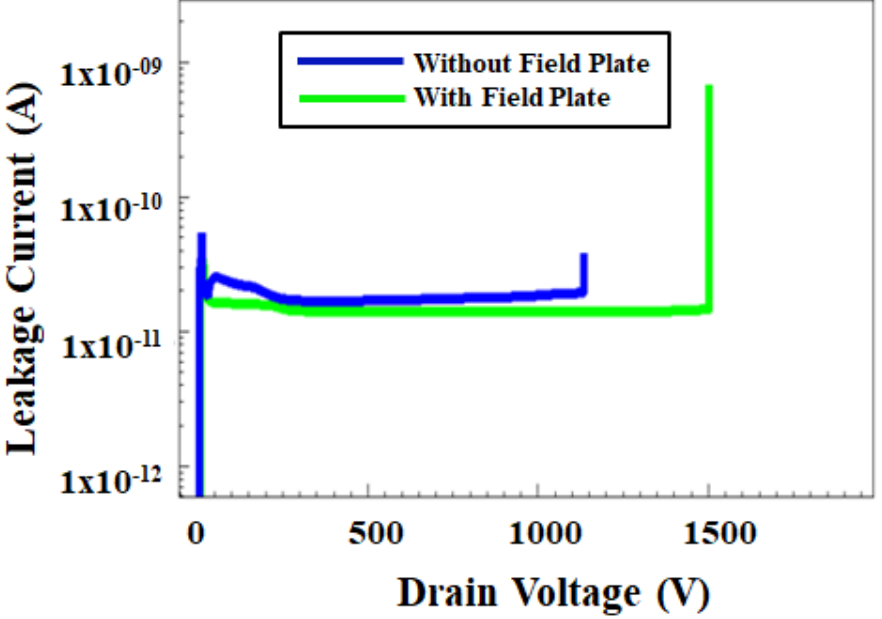
Figure 8. Simulated breakdown voltage comparison with gate field plate and without gate field plate.